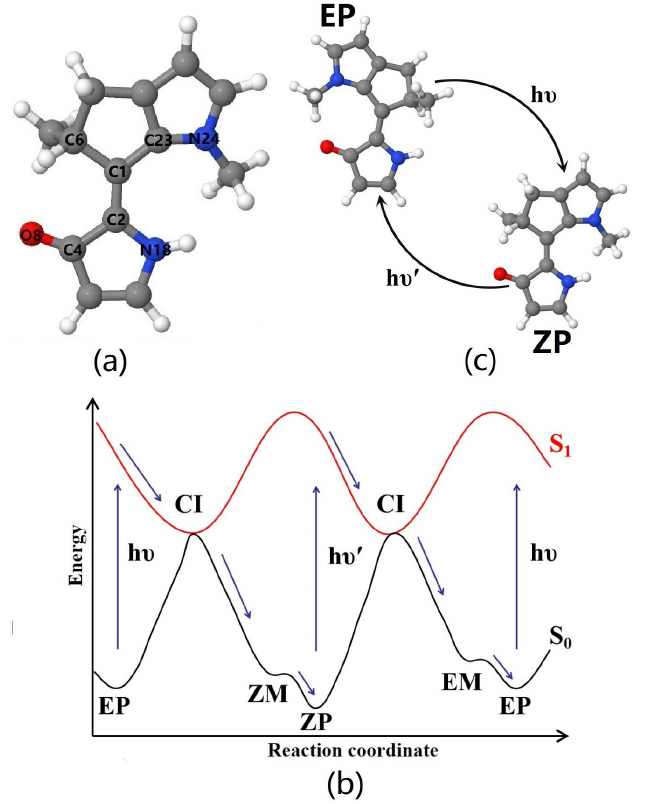
Figure 1. ( a ) Optimized geometry of ZP isomer of DDPY. Some atoms around the central C=C double bond are labeled; ( b ) the schematic diagram of ground and the first excited state potential energy profiles along the reaction coordinate of LDMRM DDPY; ( c ) the schematic diagram of a working cycle of the photon-only two-stroke LDMRM DDPY.